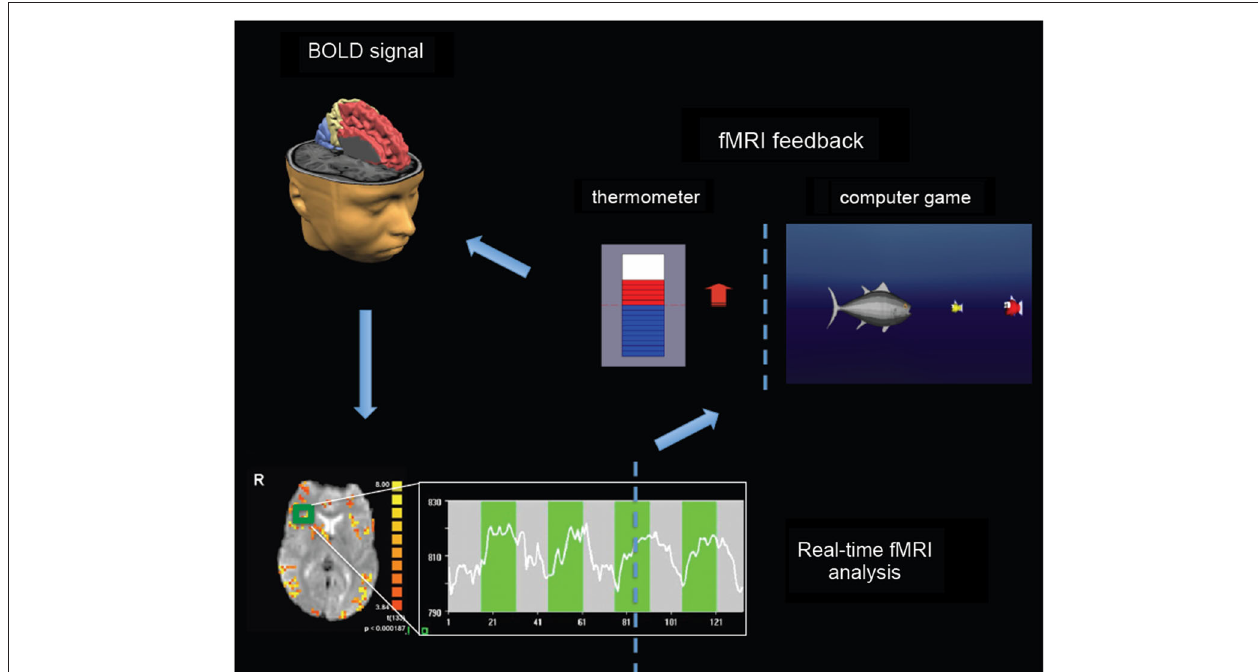
ongoing brain activity can be depicted using thermometer bars representing the actual level of BOLD activity with respect to a baseline level, and updated typically every 1–2 s. Alternative representation of visual feedback can also be implemented using computer games or virtual reality scenarios in order to increase attention, motivation and compliance of children and adolescents (e.g., by increasing the BOLD signal a fish moves towards smaller fishes—corresponding to higher level of BOLD response—to eat